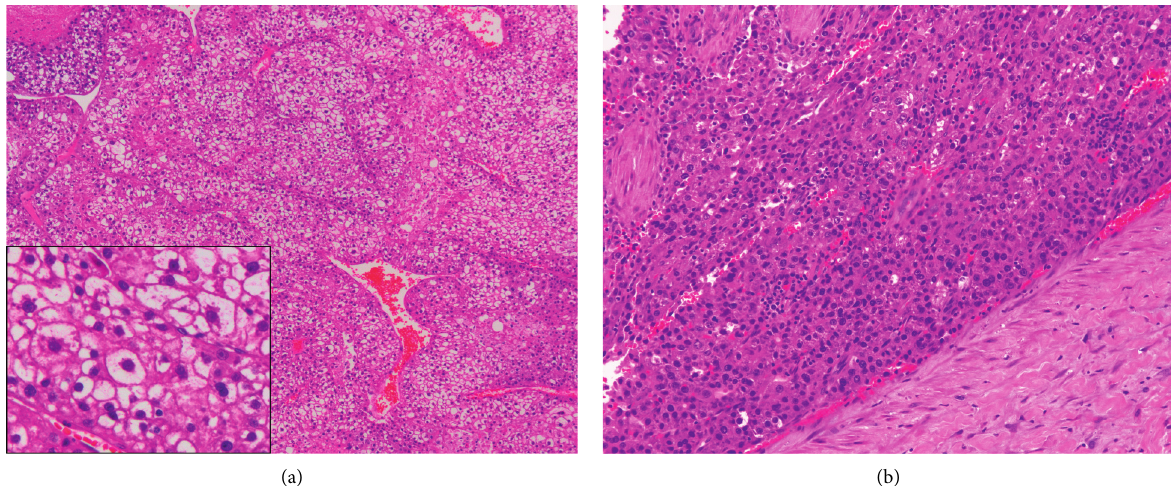
Figure 3: This hepatocellular carcinoma containing broad trabaculae of tumour cells with abundant clear cytoplasm (a). Other high-grade areas resembling conventional hepatocellular carcinoma